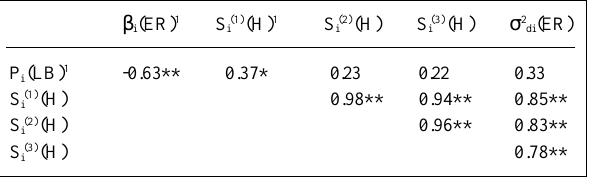
Table IV - Spearman’s coefficients of linear correlation among parameters of the Eberhart and Russell’s (1966), Lin and Binns’ (1988), and Huehn’s (1990a) models, for 20 maize hybrids evaluated in 10